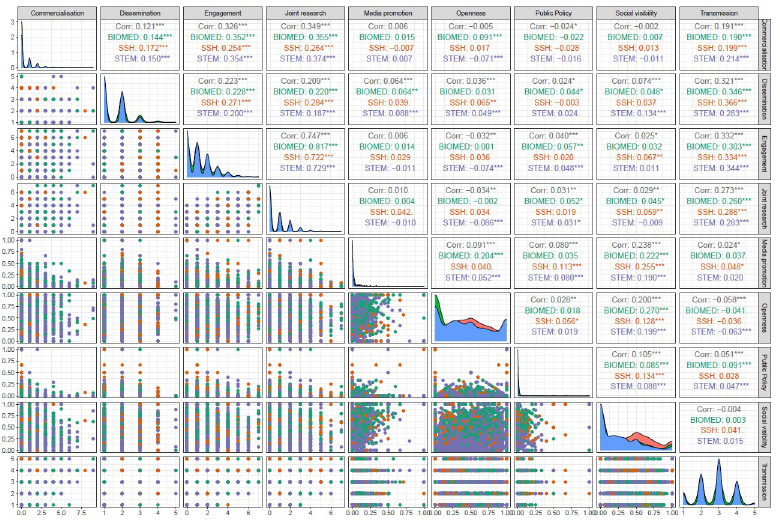
Fig 2. Distribution patterns and correlation matrix for the nine components overall and by field. BIOMED: Biomedical; SSH: Social Sciences and Humanities; STEM: Science, Technology, Engineering and Maths.